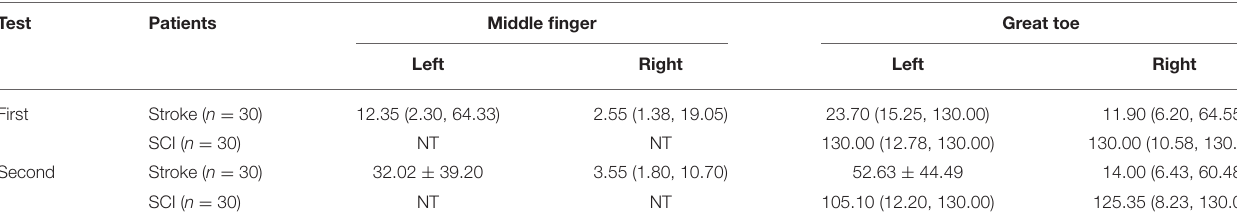
TABLE 4 | VPT results of test–retest.